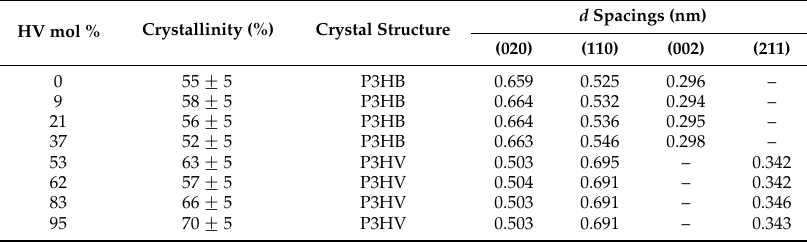
Table 1. Degree of crystallinity, crystal structure, and d spacings of PHBHV samples. Reprinted with